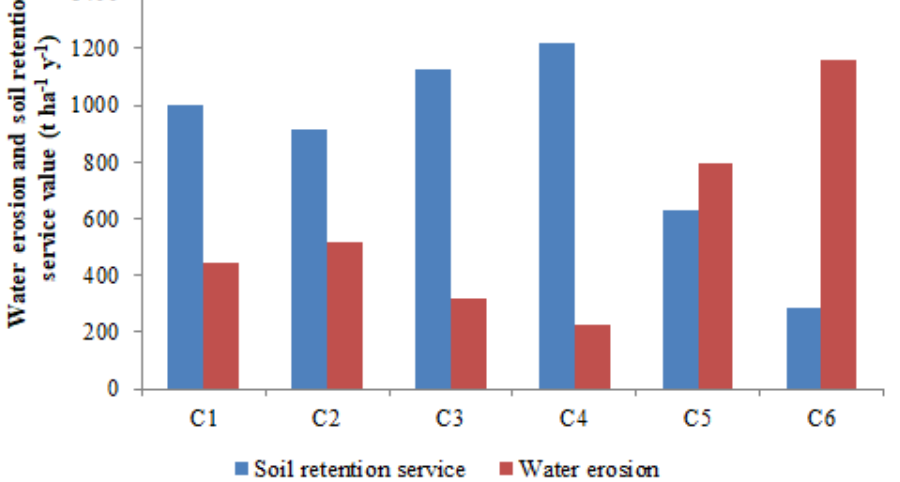
Figure 2. Water erosion and soil retention service values based on methods C1–C6 (13 years). C1–C6 represent the six C factor estimation methods shown in Table 2.